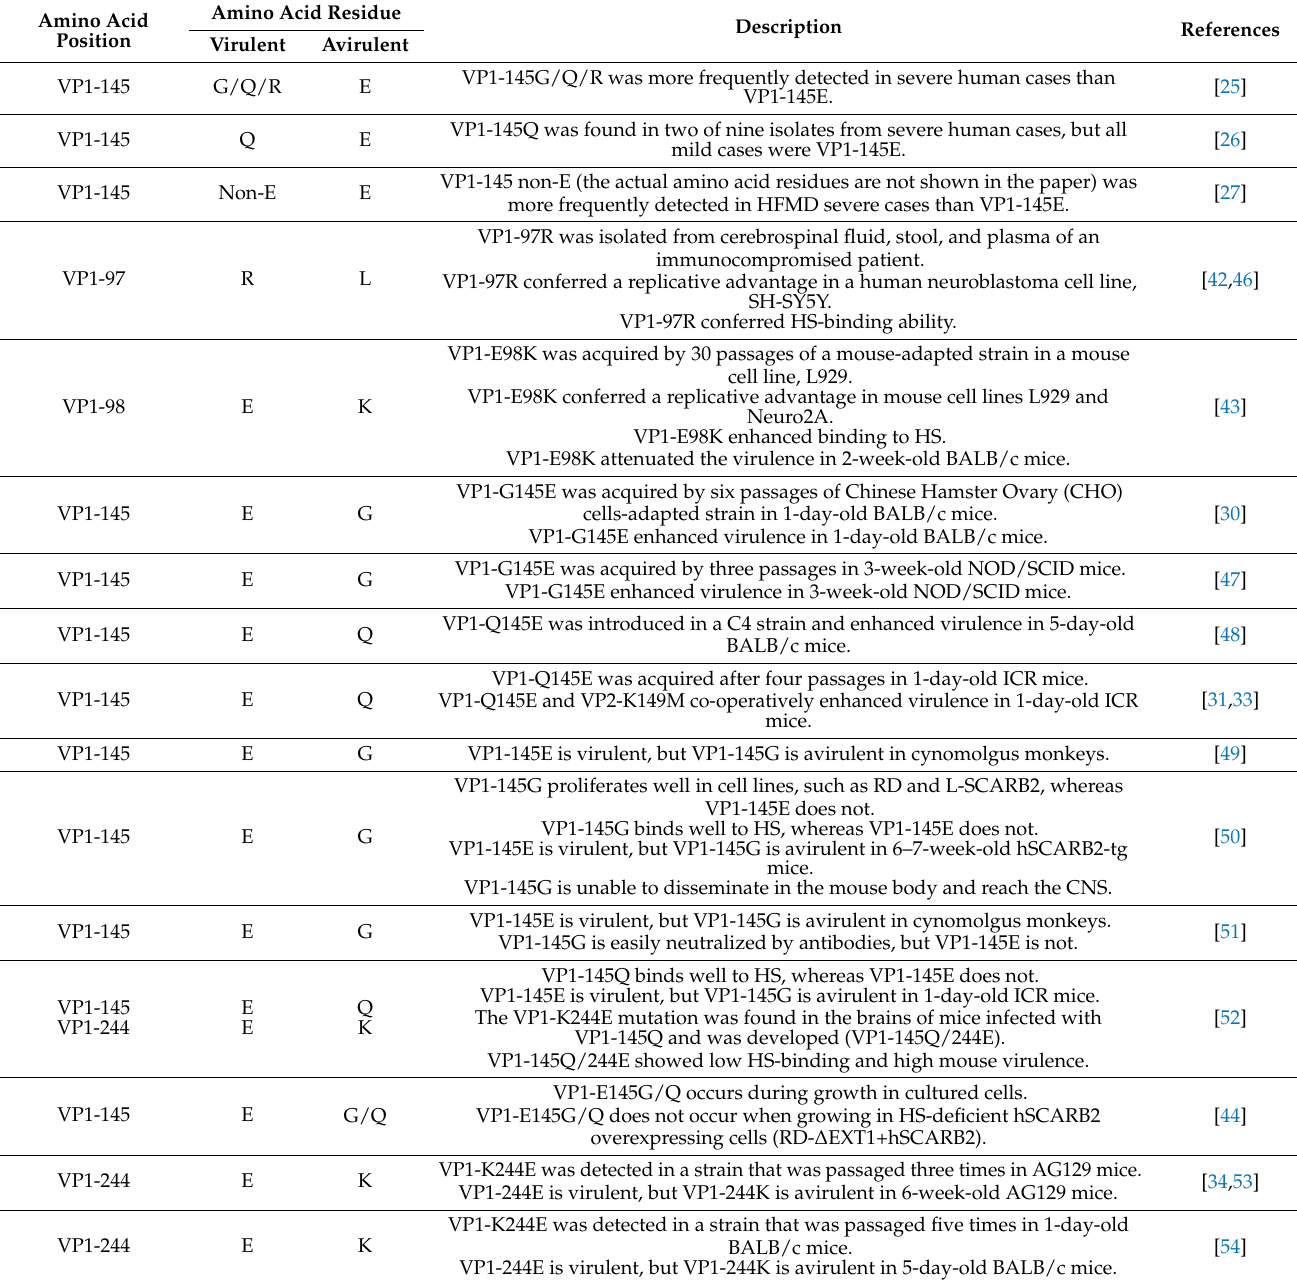
Table 1. Studies on HS-binding